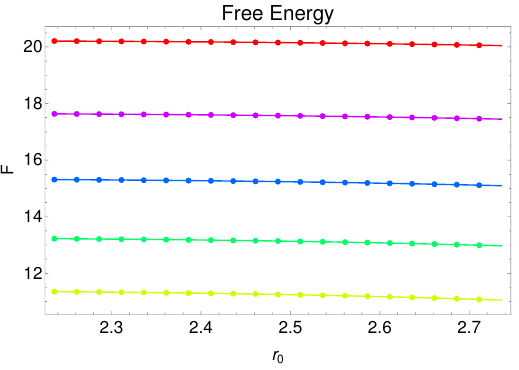
Figure 14 . Free Energy of straightish branes in black hole